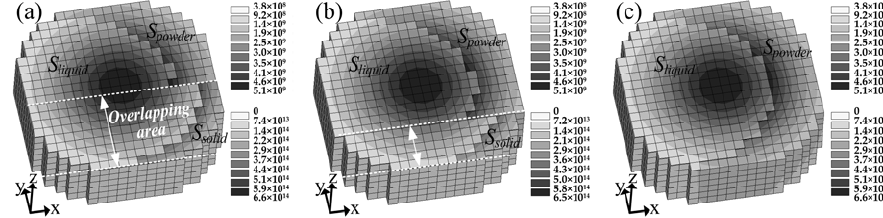
Figure 10. Area distribution of each state and their absorbed energy density distribution under the laser spot area with hatch space of ( a ) 50 μ m; ( b ) 70 μ m; and ( c ) 100 μ m.